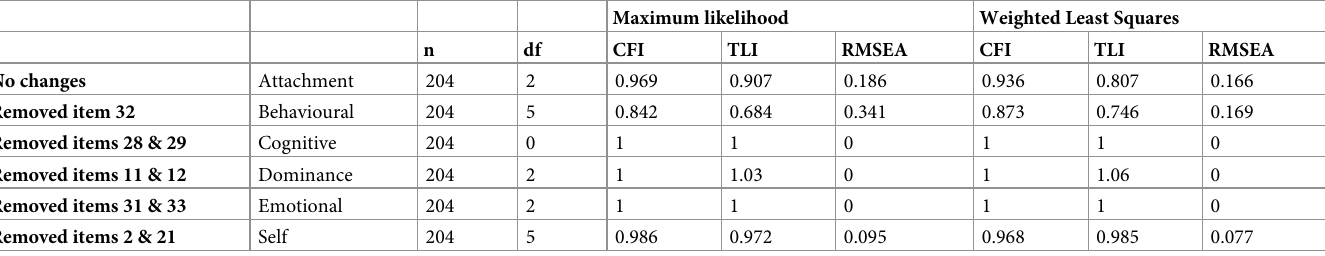
Table 8. Confirmatory factor analysis of CAPP dimensions deleting items for best